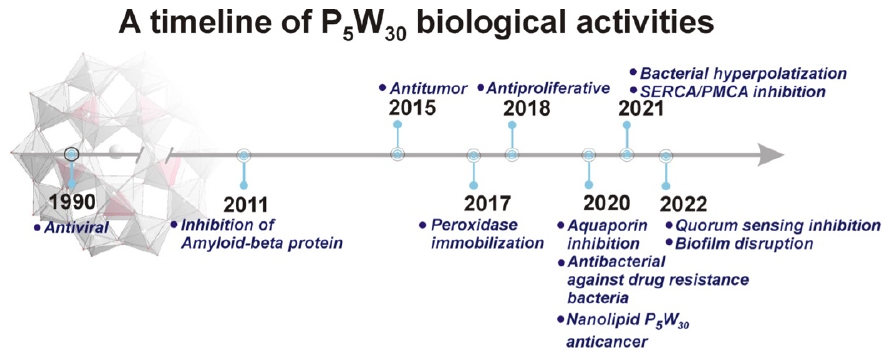
Figure 2. Timeline for P 5 W 30 biological activities: (1) 1990, Antiviral, (2) 2011, Amyloid beta inhibition; (3) 2015, Antitumor, (4) 2017, Peroxidase immobilization; (5) 2018, Antibacterial; (6) 2020, aquaporin inhibition; antimelanoma activity; (7) 2020, drug-resistance bacteria; (8) Nanolipid-loaded Preyssler for anticancer (9) 2021, bacterial hyperpolarization; (10) 2021, SERCA/PMCA inhibition; (11) 2022, antiquorum sensing; (12) biofilm disruption.